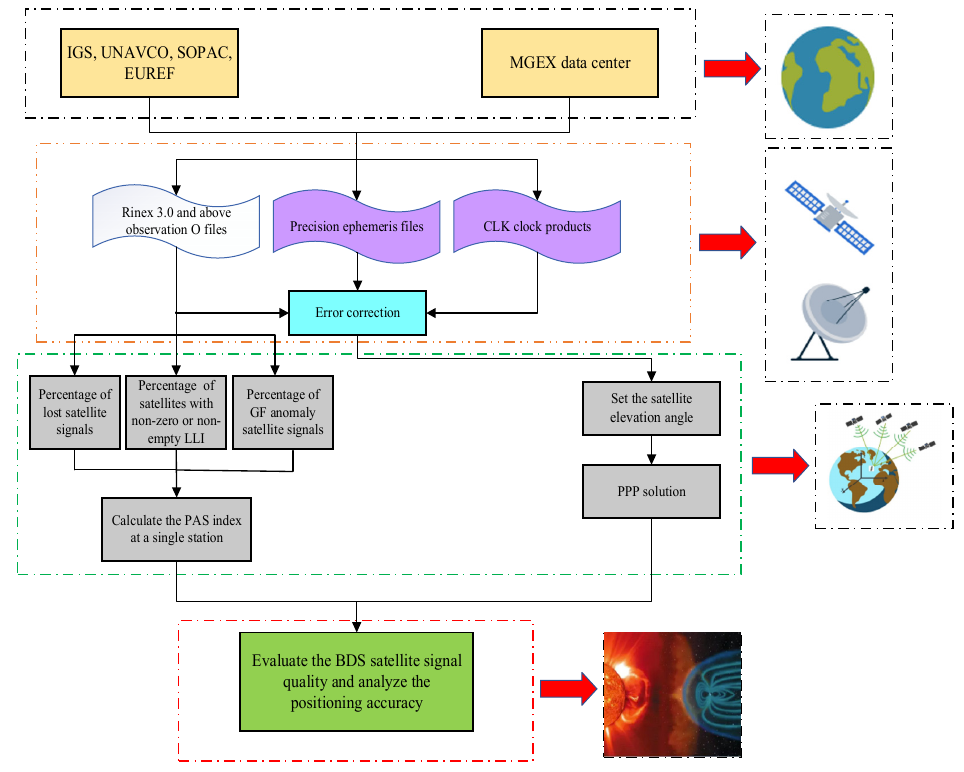
Figure 3. Data processing flow for BDS satellite signal quality evaluation and positioning accuracy analysis.